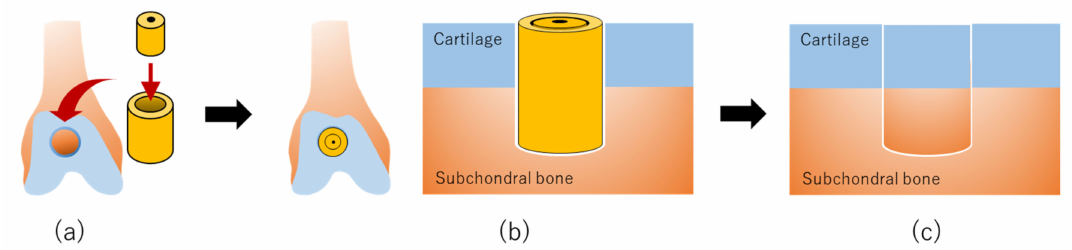
Figure 4. The production of sca ff old-free AT-MSC constructs using “Kenzan” for osteochondral regeneration in vivo: ( a ) Sca ff old-free cell construct is prepared for implantation. ( b ) A sca ff old-free cell construct is implanted into an osteochondral defect. ( c ) Mesenchymal stem cells (MSCs) in the construct are di ff erentiated to chondrocytes and osteocytes, followed by regeneration of articular cartilage in the surface layer and formation of subchondral bone in the deep layer at the implanted